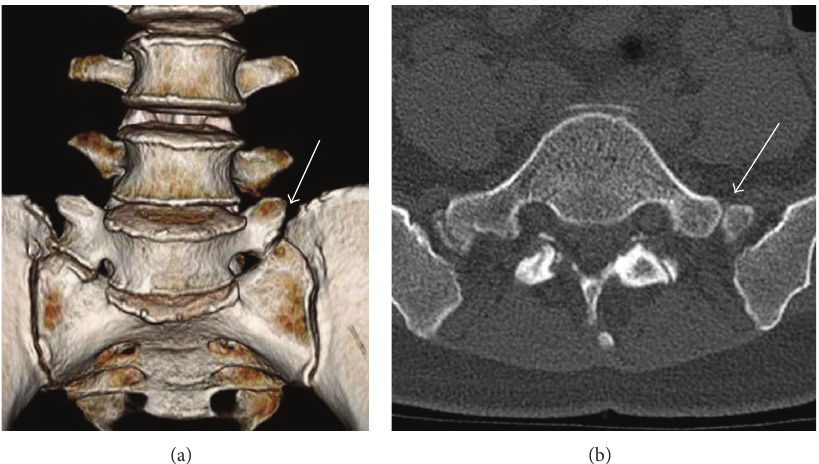
Figure 1: Three-dimensional reconstructed image (a) and axial image (b) showing bilateral articulation (arrow).